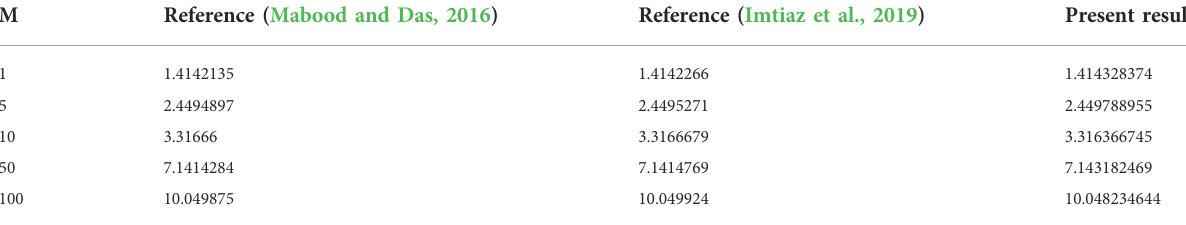
TABLE 1 Contrasting outputs of − f 99 ( 0 ) for selected values of M when K (cid:1) ∞ and β (cid:1) 0 .